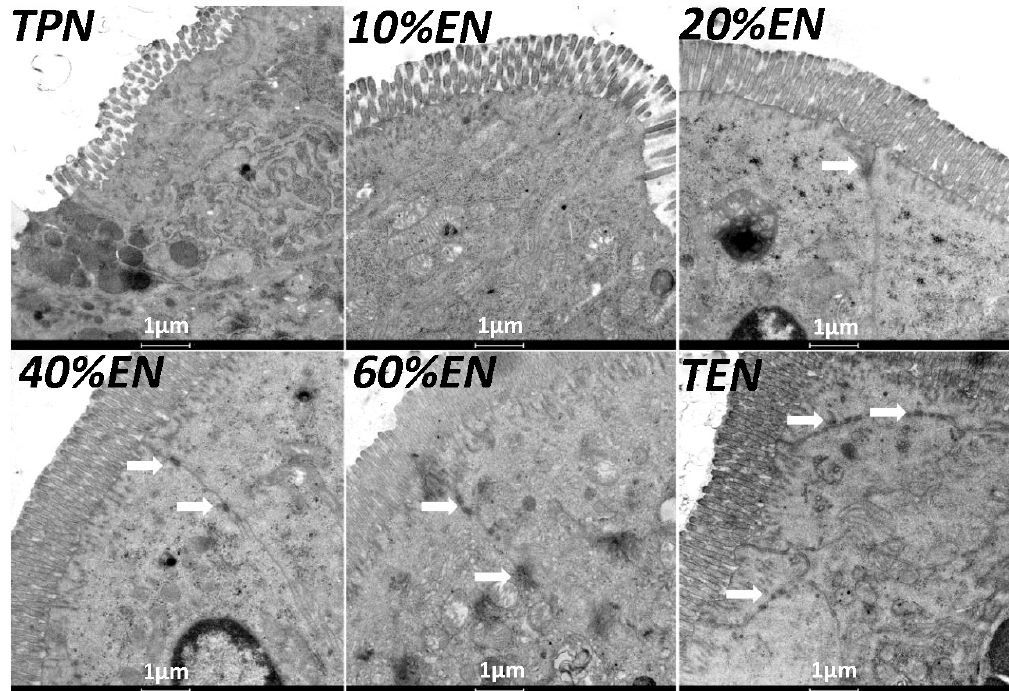
Figure 3. Transmission electron microscopy of intestine of all the groups. This demonstrated that microvilli were visibly damaged and atrophic in TPN and 10%EN groups. While in 20 and more EN dose groups, microvilli had relatively normal integrity. TJ (white arrow) were also relatively intact in 20%, 40%, 60%, and TEN groups. In TPN and 10%EN groups, TJ protein complex was hardly observed compared with the 20% and more EN dose groups.